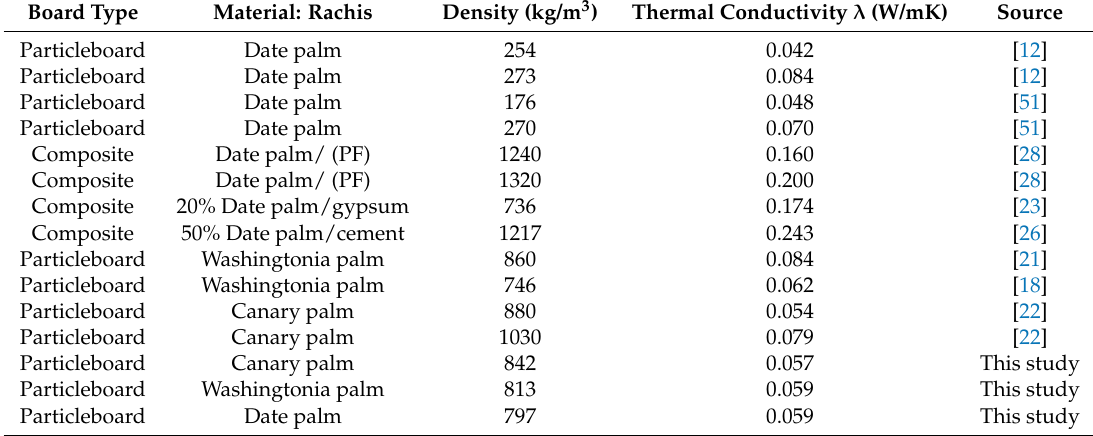
Table 7. Average thermal conductivity values of palm particleboards studied by different